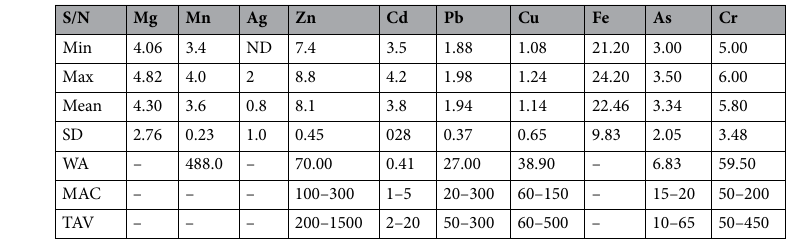
Table 4. Concentration of HMs in the selected top-soil of the control site in ppm. ND not detectable, WA world/global average for background contents, MAC maximum allowable concentration in soil, TAV trigger action value 4,43–45 .